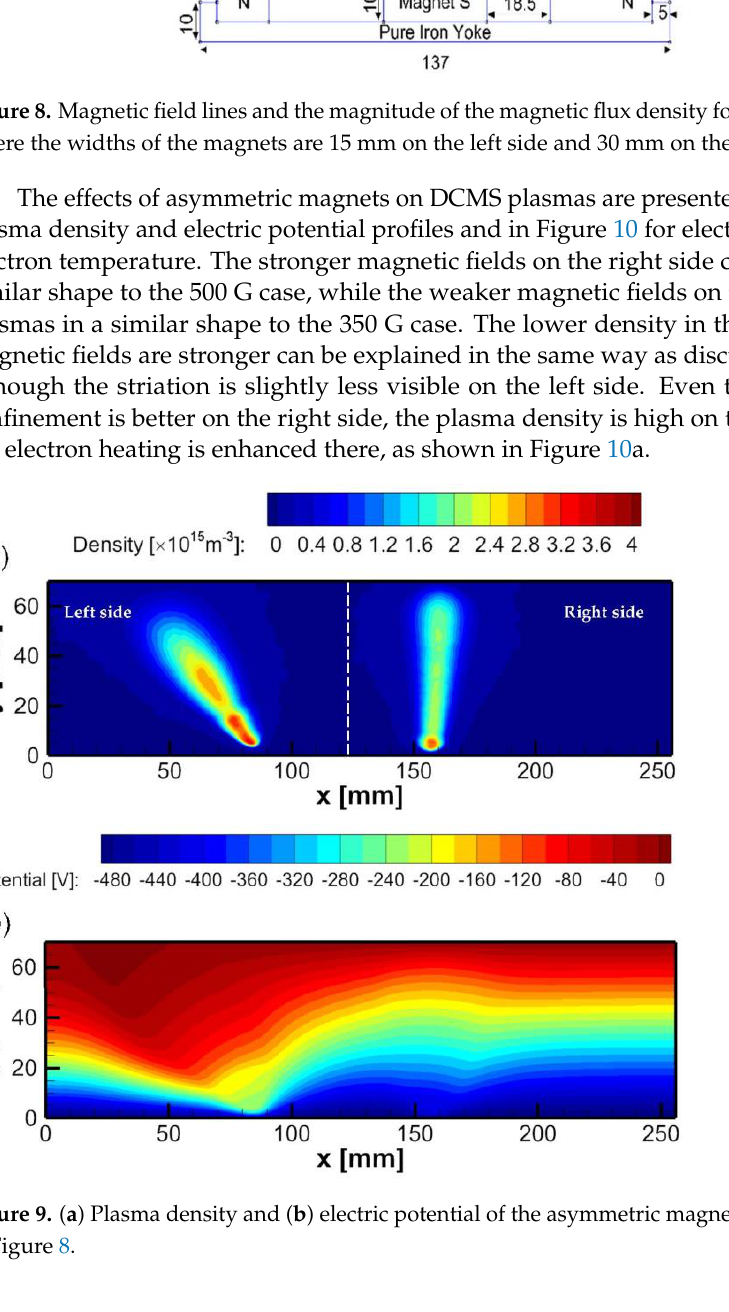
in Figure 8. in Figure